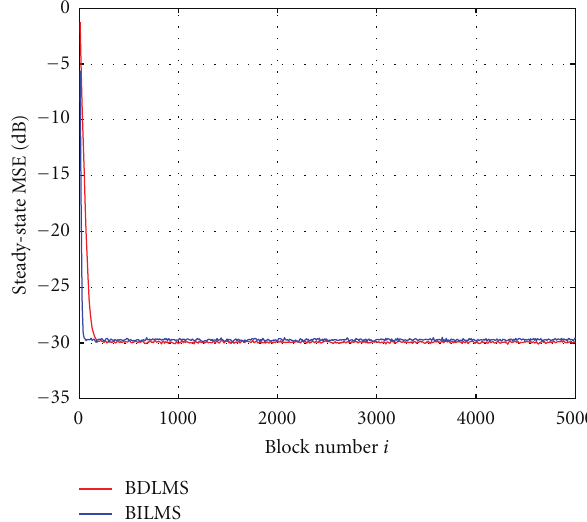
Figure 13: Global mean-square error curve for BILMS and BDLMS.